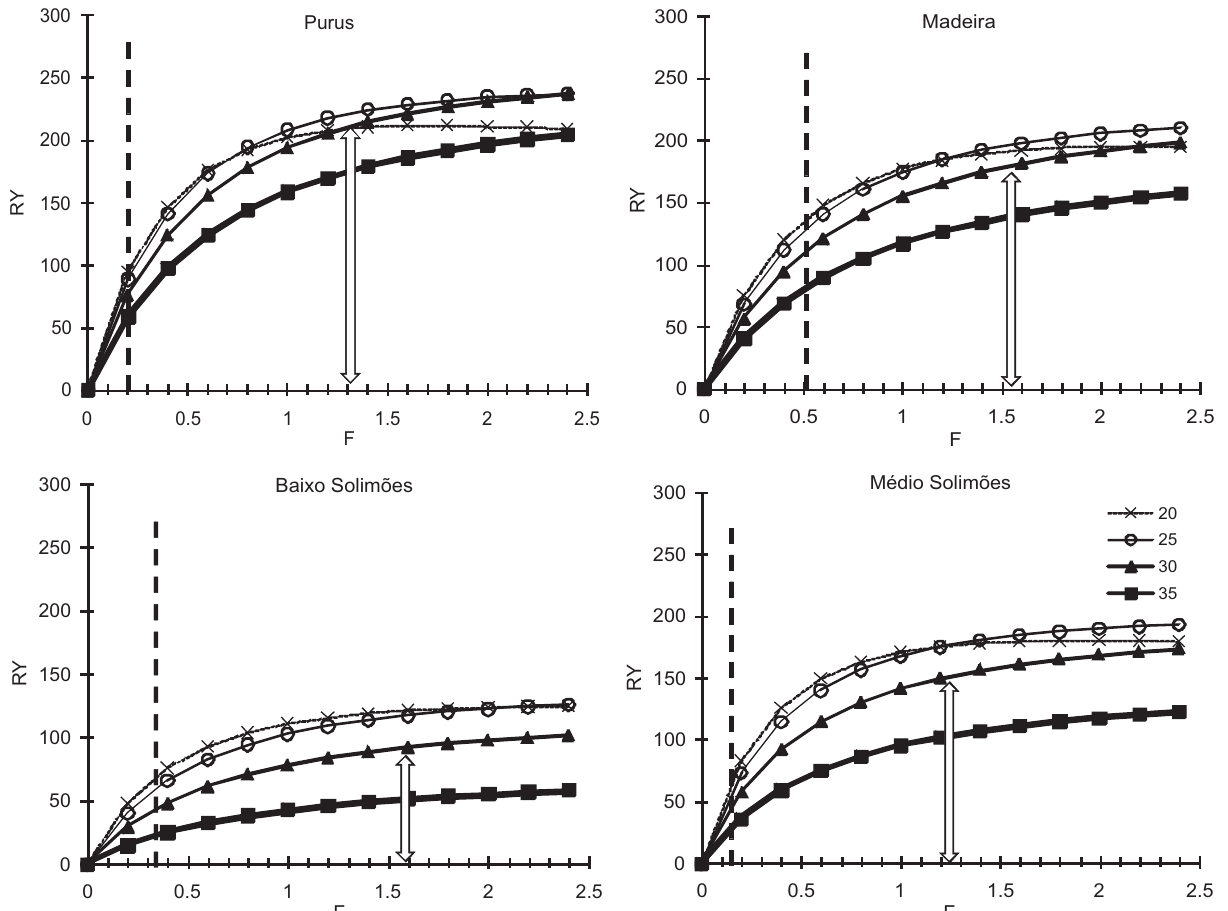
Figura 8. Curvas de rendimento por recruta (Y/R) da matrinxã por sub-sistema contra a mortalidade por pesca (F) para diferentes comprimentos de recrutamento pesqueiro (em cm) indicados na legenda. A linha tracejada vertical indica o nível de F atual e a seta dupla vertical ao nível estimado de F 0,1